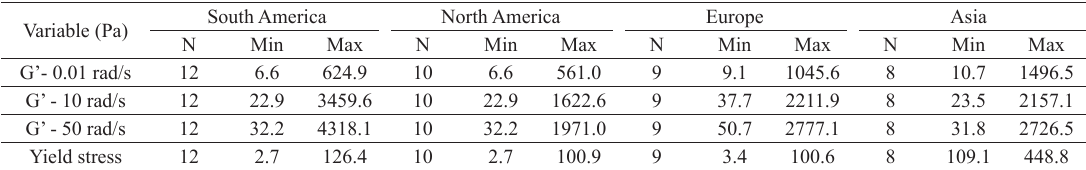
Table 8. Range of values for rheological properties which define the space for the prediction of sensorial aspects of cosmetic emulsions. Variable (Pa) G’- 0.01 rad/s G’ - 10 rad/s G’ - 50